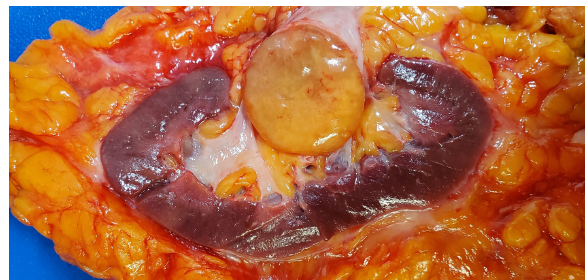
Figure 2: Gross resection specimen of the left renal hibernoma.